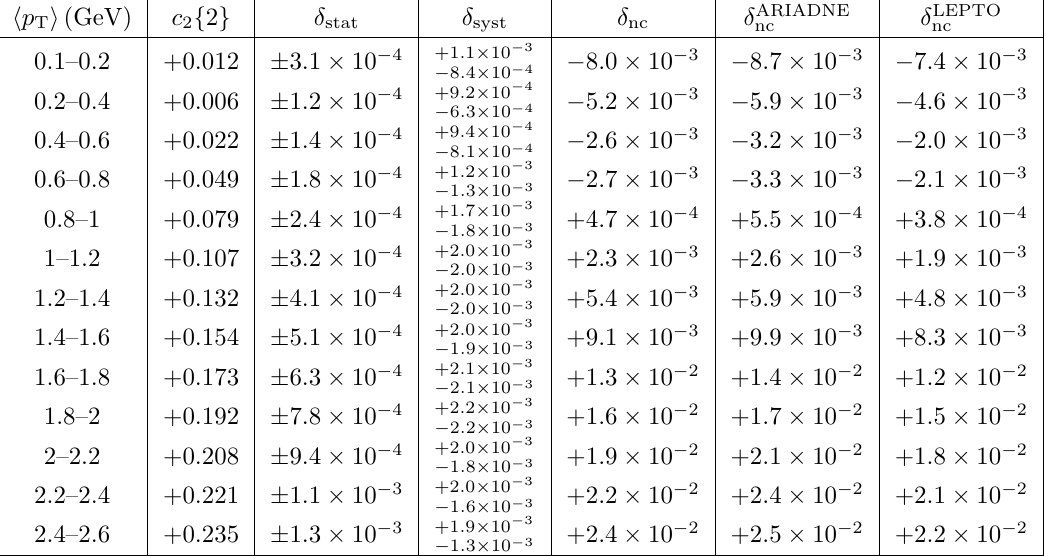
Table 26 . c 2 f 2 g versus h p T i from (cid:12)gure 12 (b), 15 (cid:20) N ch (cid:20) 30, p T > 0 : 1 GeV, no j (cid:1) (cid:17) j cut; (cid:14) stat , (cid:14) syst and (cid:14) nc denote the statistical, systematic and Monte Carlo non-closure uncertainties,